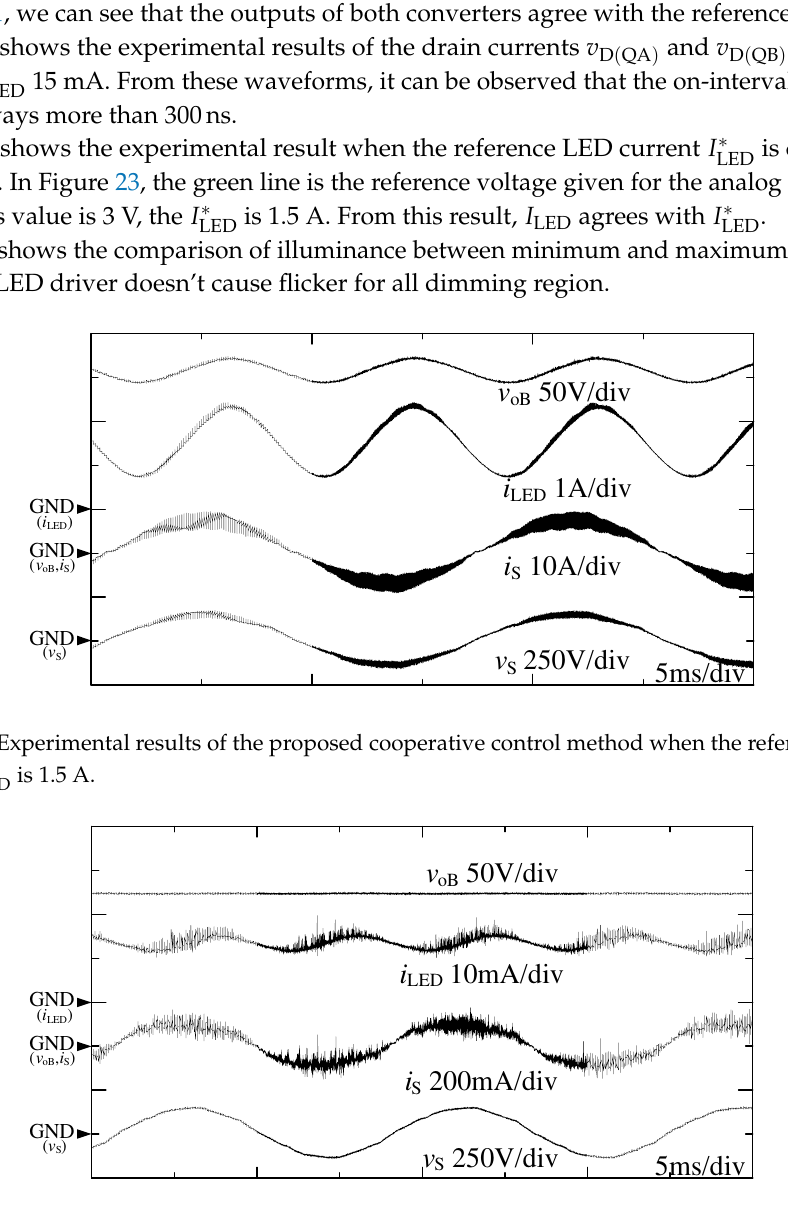
Figure 18. Experimental results of the proposed cooperative control method when the reference LED current I ∗ is 15 LED